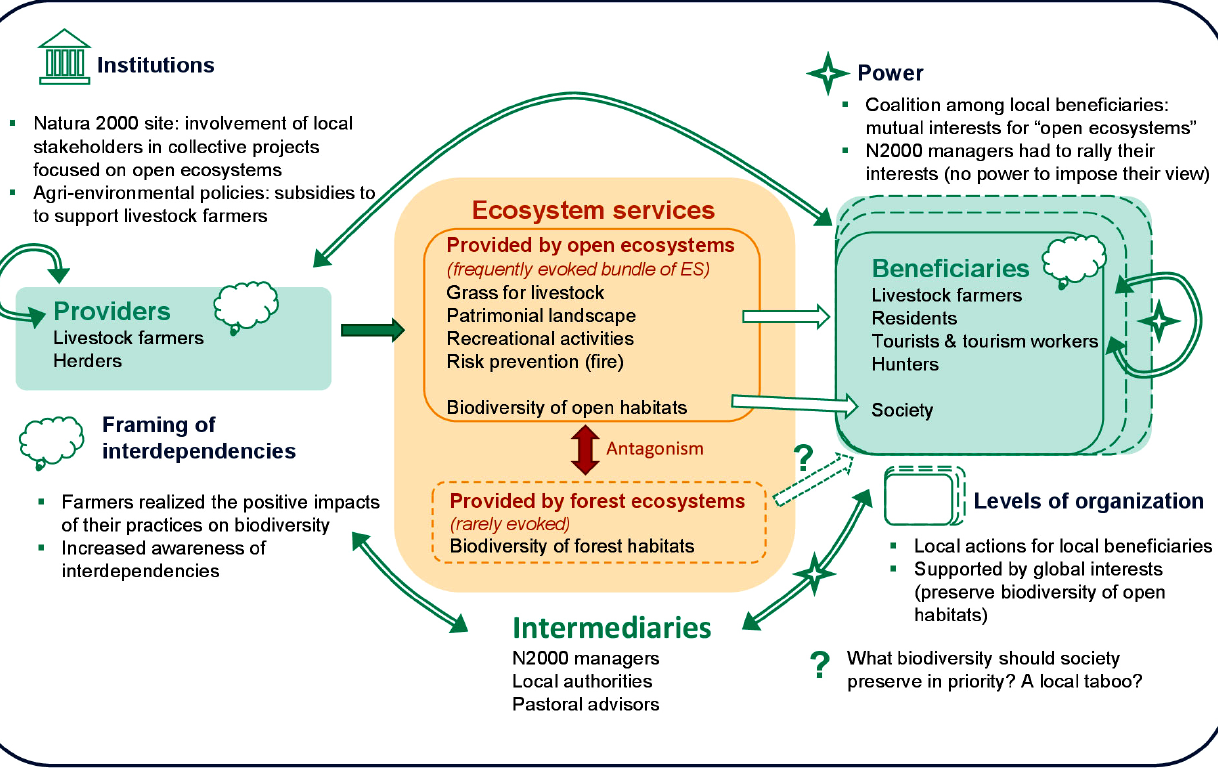
Fig. 2 . Example of an existing action arena in a Natura 2000 site on the issue of closing landscapes in pastoral agroecosystem in the French